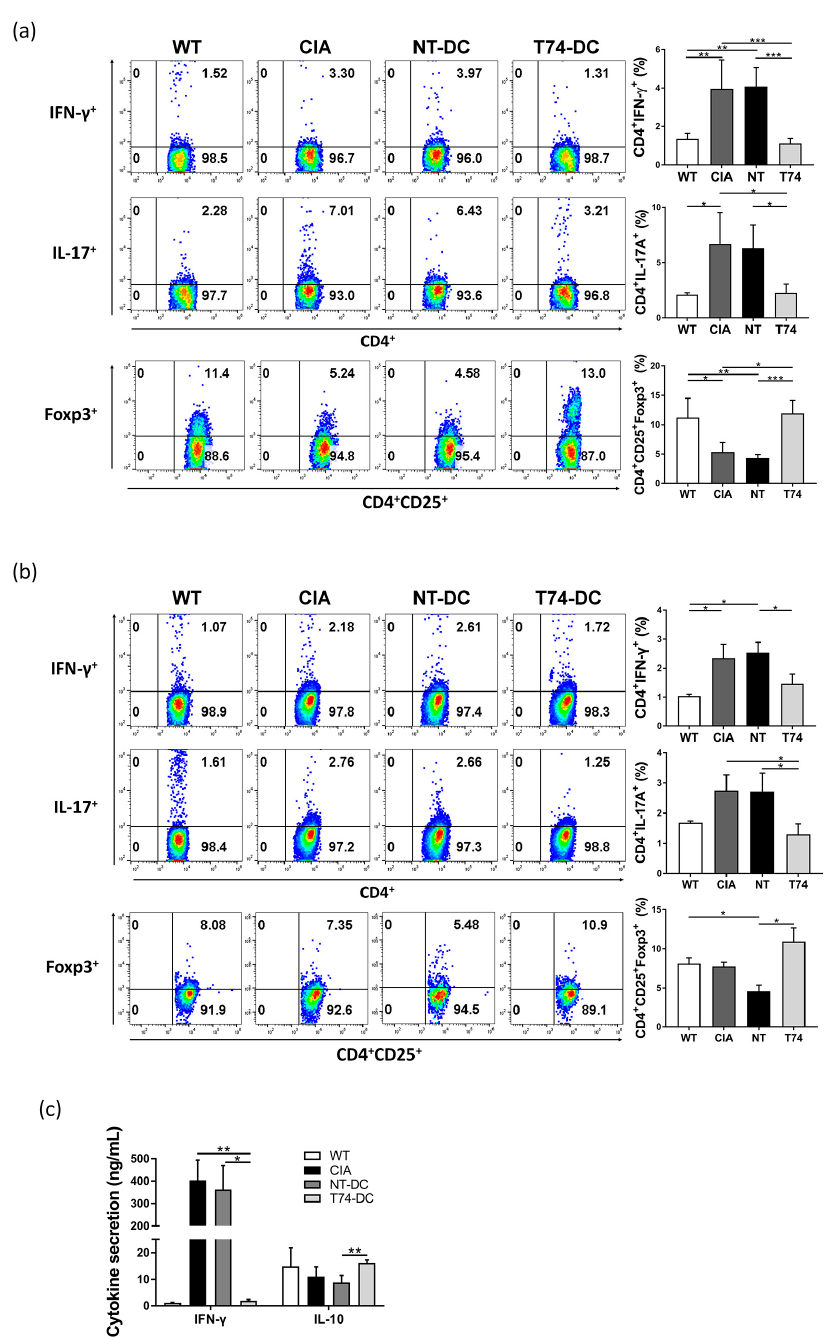
Figure 6. T74-DCs modulate systemic T cell-mediated immunity in CIA mice. ( a ) Splenocytes and ( b ) lymph node cells were isolated from each group of mice, cultured with CII (50 μ g/mL) for 72 h, and analyzed by flow cytometry. The percentage of Th1, Th17, and Treg cells is shown on the dot plots. Data are representative of independent DC preparations. ( c ) Splenocytes from each group of mice were restimulated with CII and the culture supernatants were collected after 72 h. Th1- and Treg-related cytokine (IL-10 and IFN- γ ) levels in culture supernatants were measured using commercial ELISA kit. Data in panels are expressed as the mean ± SEM (wild type: n = 3, other groups: n = 5). * p < 0.05, ** p < 0.01, *** p < 0.001. N/D: not